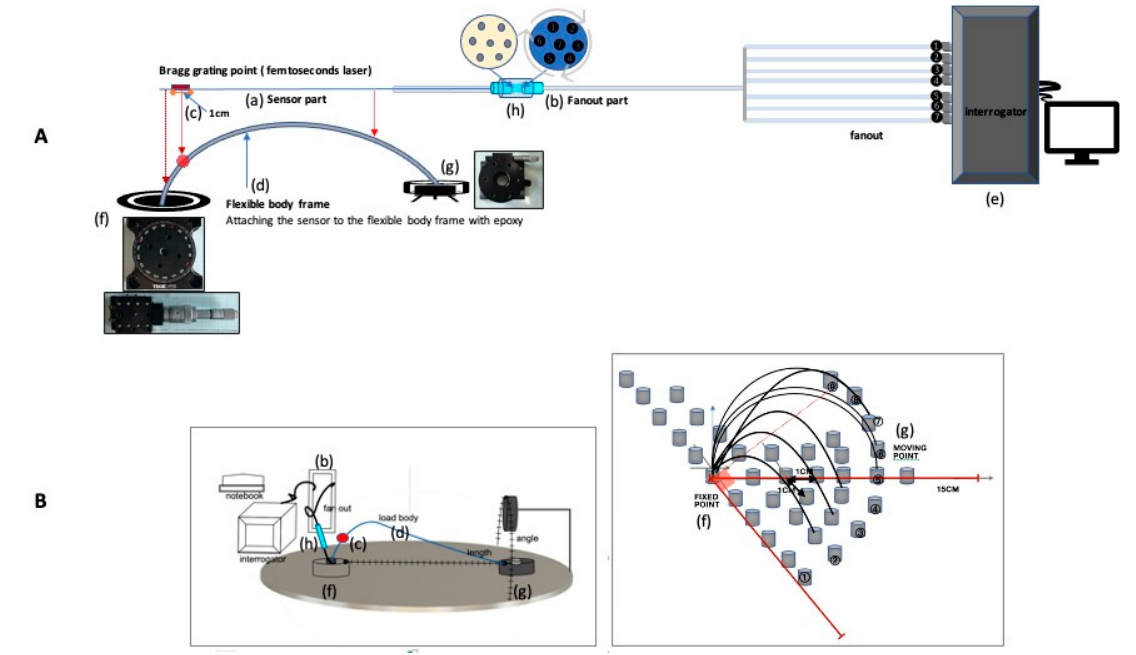
Figure 4. A (a–h) Configuration diagram of experimental measurement device; B (b–d,f–h) Appearance of the experimental measurement device, diagram of the experimental protocol; A (a) manufactured sensor; A (b) sensor with the 7-core measurement fanout; A (c) short-period Bragg grating position; A (d) flexible loading body frame; A (e) interrogator and notebook; A (f) and B (f) center fixed point manual stage of the sensor movement; A (g) and B (g) strain deformation measurement the moving point and manual measuring stage; A (h) schematic of the ferrule connection between the sensor part and fan-out measurement part; B . Configuration diagram and experiment method sequence diagram of the actual test equipment.